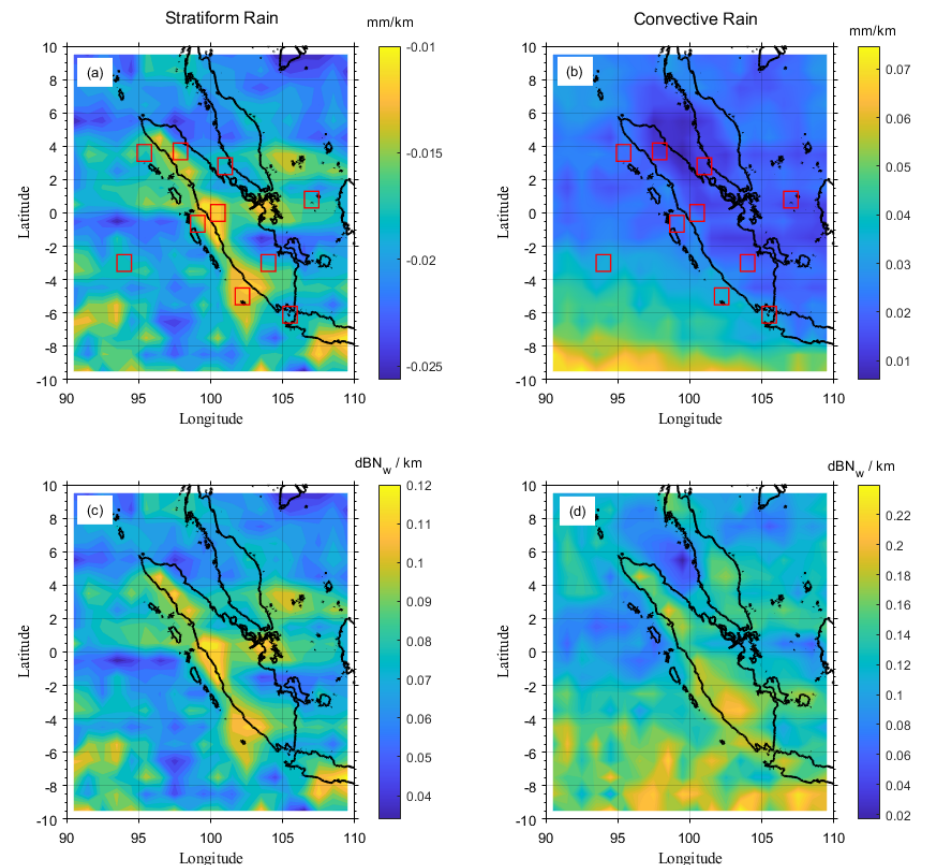
Figure 3. Spatial distribution of vertical gradient of D m for stratiform (a) and convective (b) rains, and for N w (c and d). The gradient was calculated at the altitude of 1.5 - 4